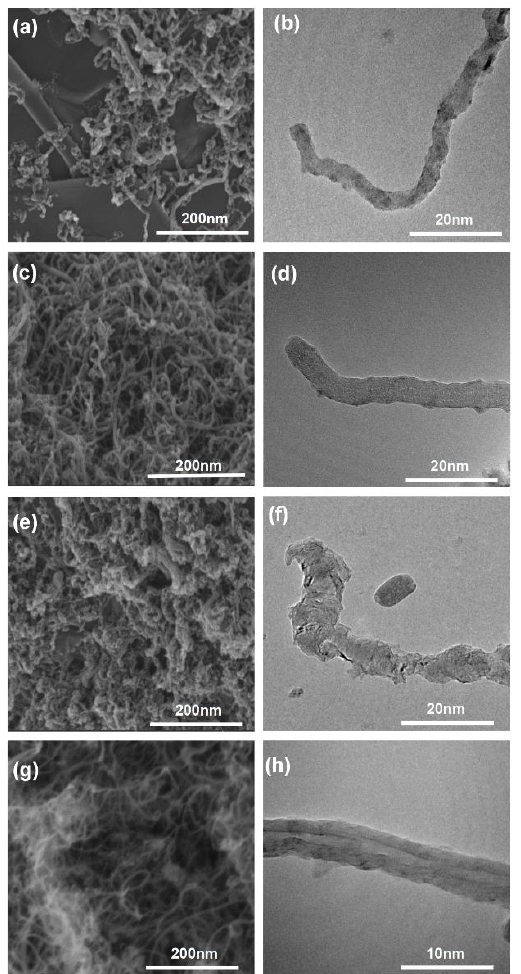
Figure 3. SEM images of MWCNTs and VGCFs prepared at different temperatures dispersed on the surface of expanded graphite and TEM images of individual fibers: ( a , b ) − 600 °C VGCFs; ( c , d ) − 700 °C VGCFs; ( e , f ) − 800 °C VGCFs; ( g , h ) − 800 °C MWCNTs.